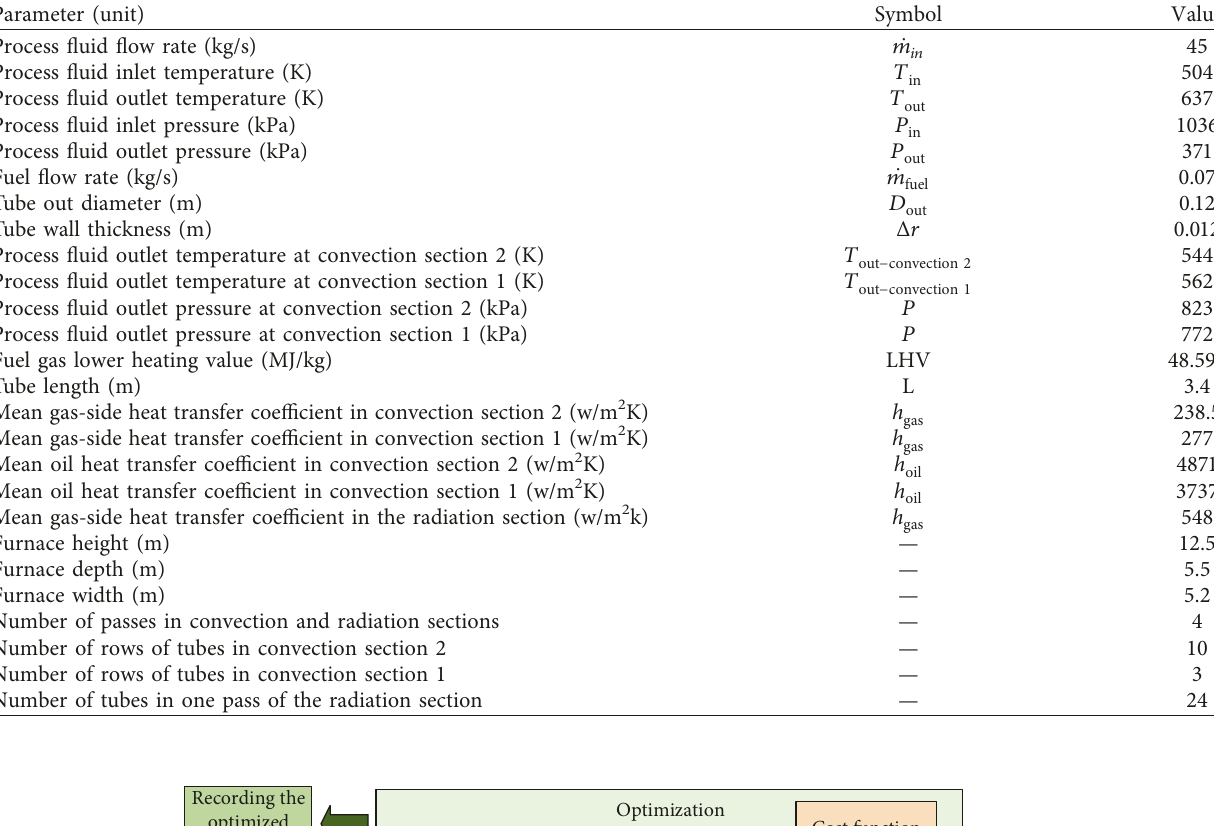
Table 1: The nominal parameters of the furnace.